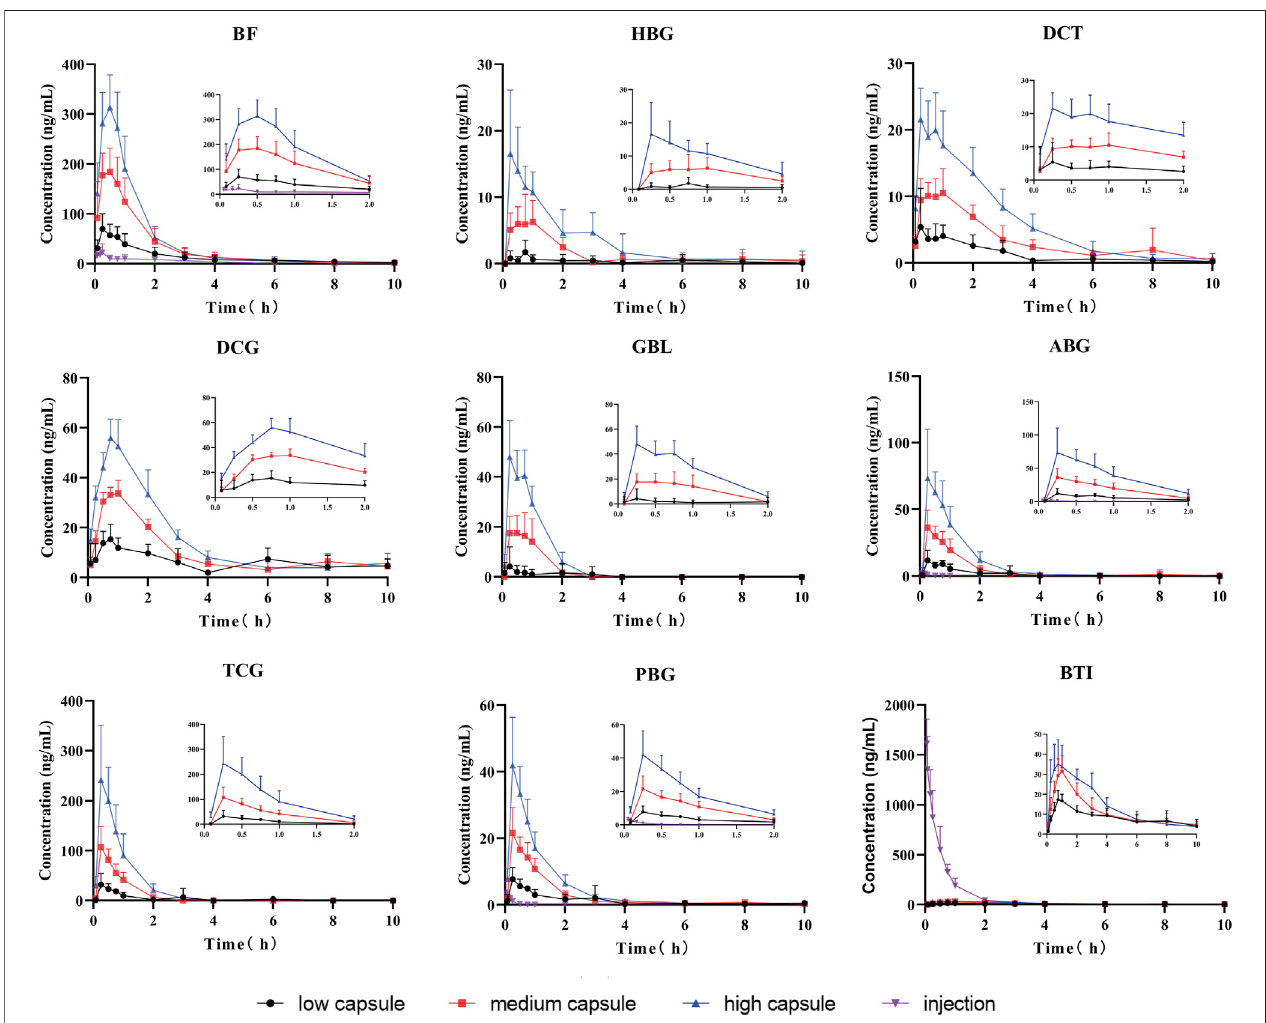
FIGURE 3 | Mean concentration – time curves of nine compounds in rat plasma after the oral administration of cinobufacini capsule (0.9, 1.8, and 3.6 g/kg) and intravenous administration of cinobufacini injection at a dose of 9 ml/kg to male SD rats (mean ± SD, n = 6).